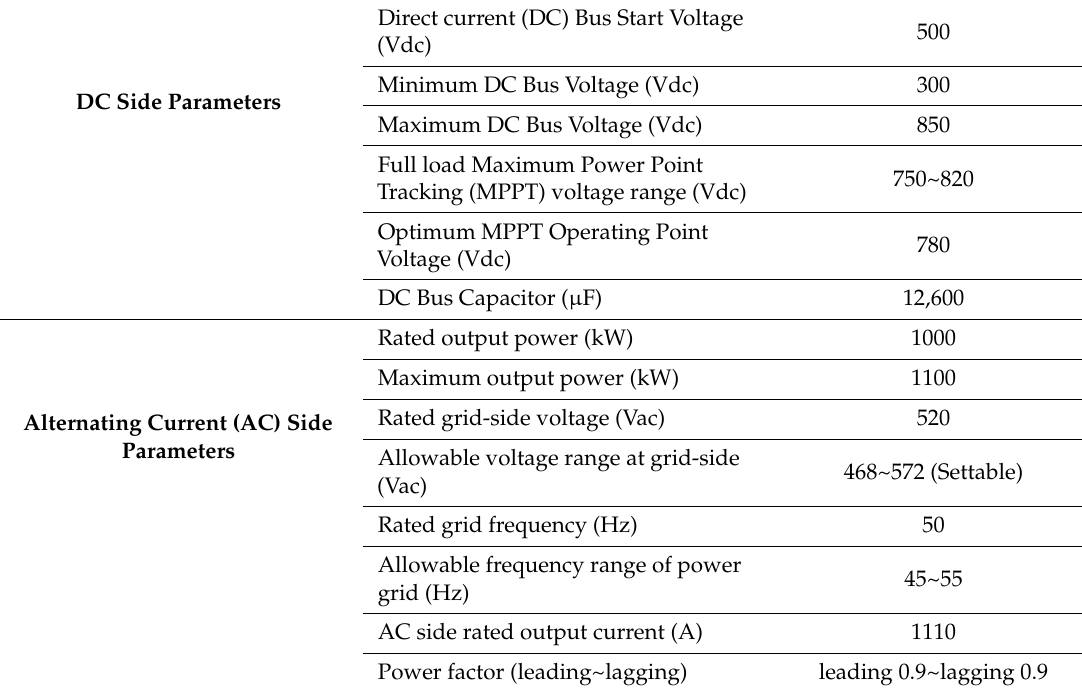
Table 2. Parameters of photovoltaic inverters to be measured.